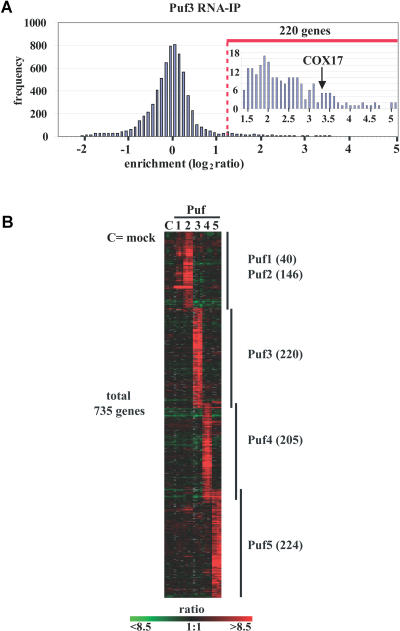
Defining Puf Target RNAs(A) Distribution of average Cy5/Cy3 fluorescence ratios from four independent microarray hybridizations analyzing Puf3p targets. The arrow depicts enrichment of COX17 mRNA, which is known to bind to Puf3p (Olivas and Parker 2000). The red dashed line indicates the threshold applied for defining 220 target RNAs (a magnification is shown of the enriched region).(B) Cluster of RNA targets for Puf proteins. Rows represent genes (unique cDNA elements) and columns represent individual experimental samples. Each Puf protein and an untagged strain (mock control) were assayed in quadruplicate. The color code indicates enrichments (green–red color scale). The number of mRNAs interacting with each Puf protein is indicated in parentheses. mRNAs clustering with the mock controls were removed as false positives (see Materials and Methods).